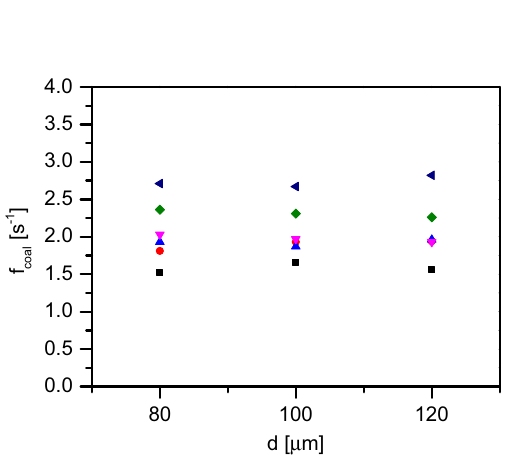
Figure 5. Coalescence trends with different droplet sizes and temperatures at 0.1 mM SDS concentration. Different symbols denote the various temperatures at which the coalescence was measured: 20 ◦ ◦ squares), 30 C (red circles), 40 C (blue upward triangles), 50 ◦ diamonds) and 70 C (dark blue leftward